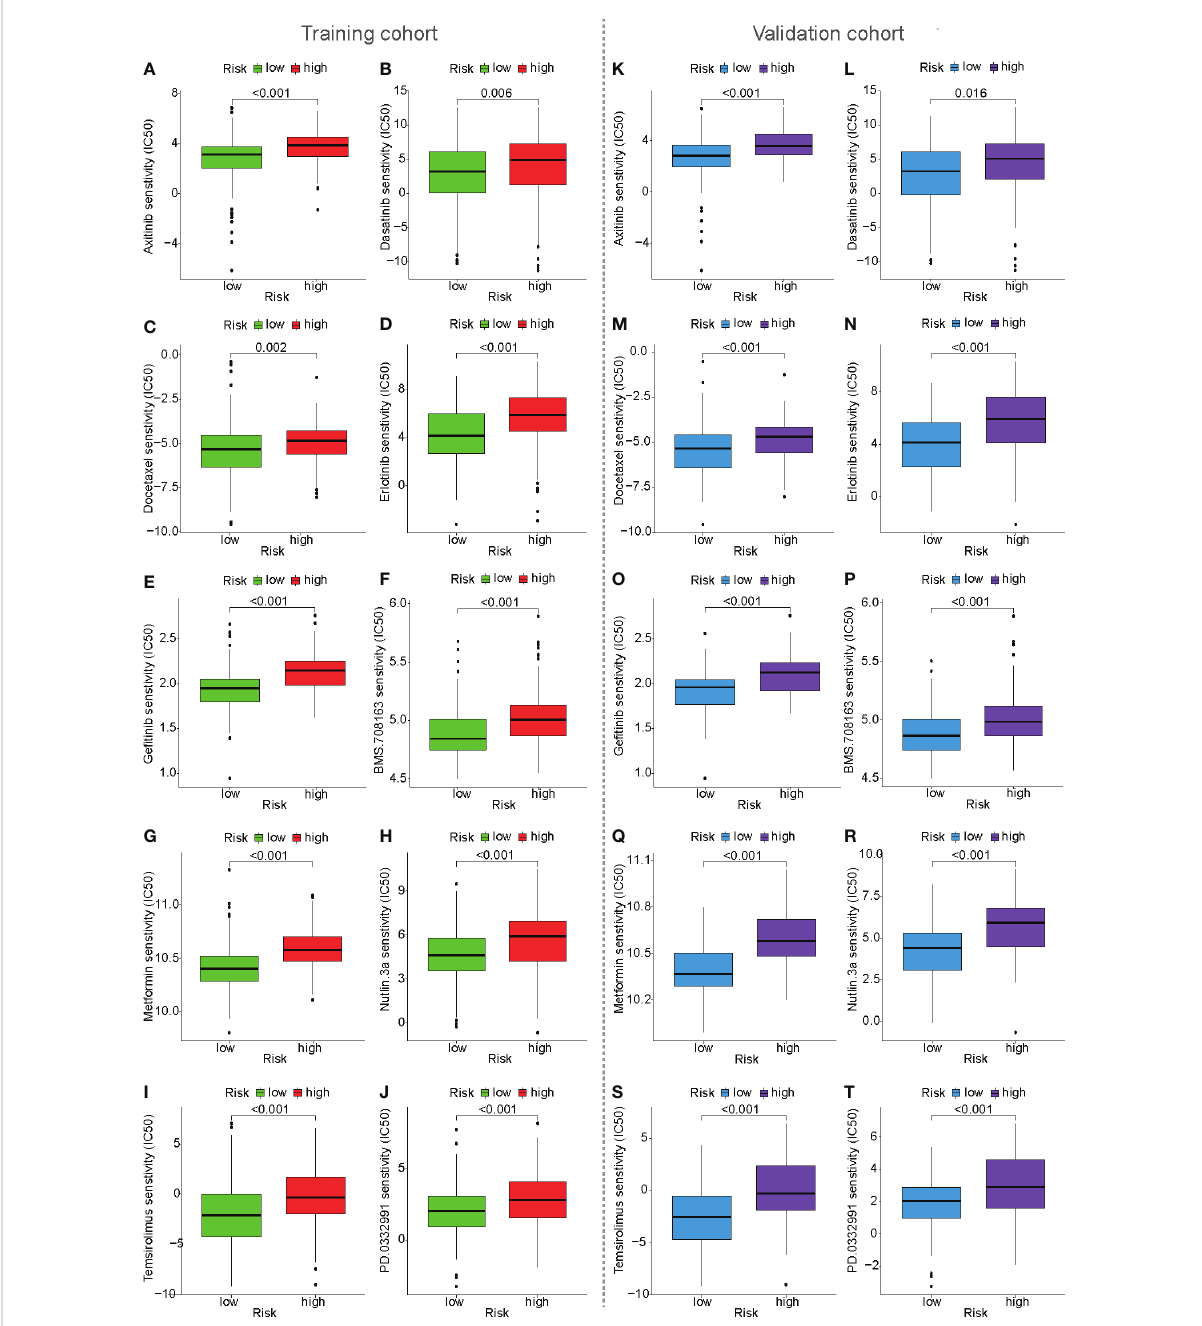
FIGURE 9 Prediction of drug sensitivity based on mfrlncRNA signature. (A – J) Prediction of drug sensitivity between high- and low-risk populations in the training cohort. (K – T) Prediction of drug sensitivity in the validation